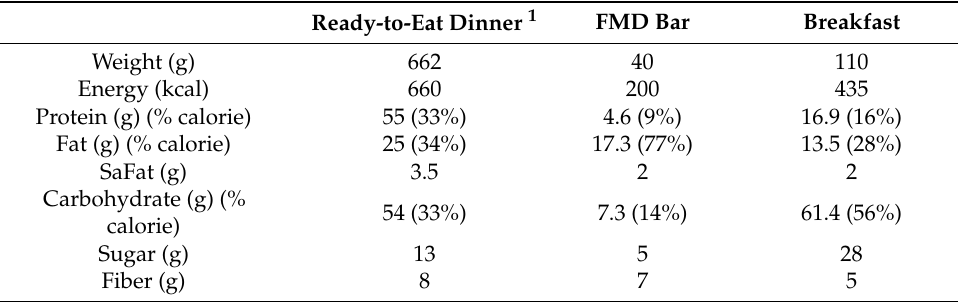
Table 1. Macronutrient composition of the study